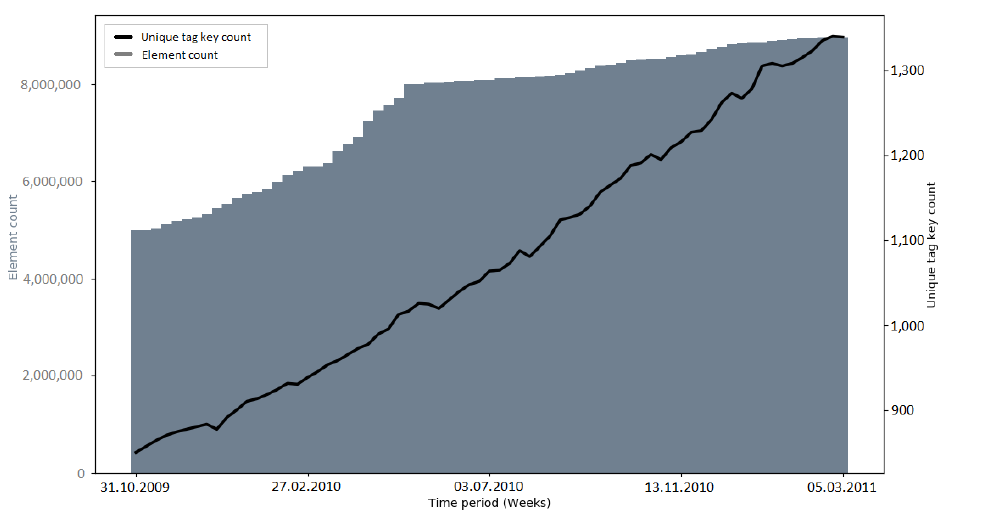
Figure A17. Number of tag keys during the 3dShapes